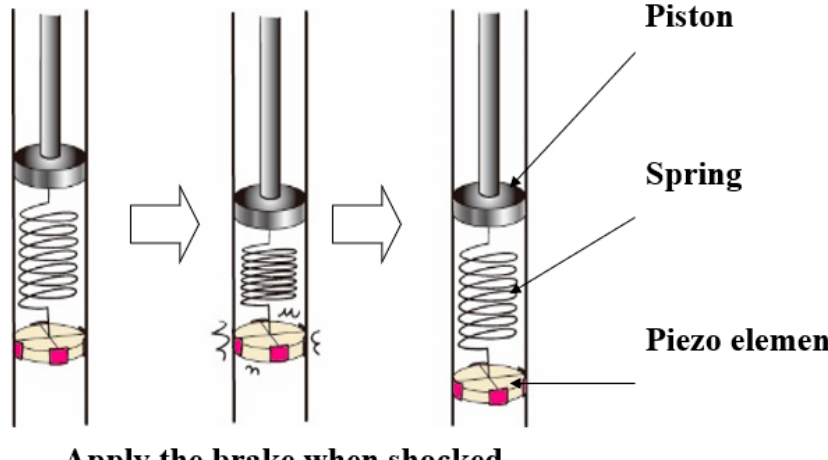
Figure 4. Schematic of cylinder inside.